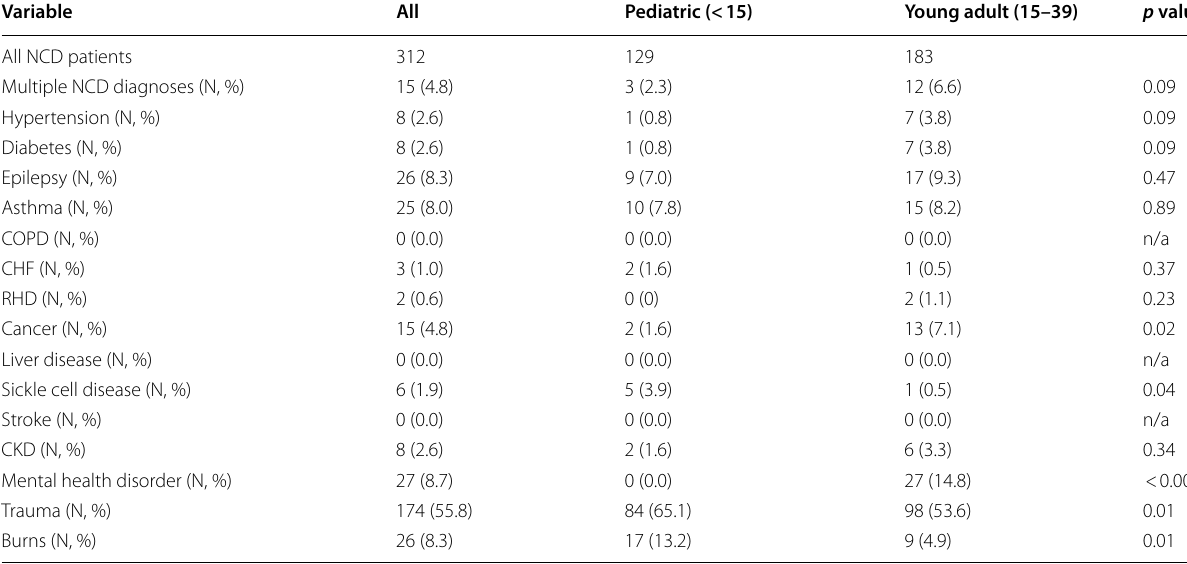
Table 3 Distribution of NCDs among the younger population